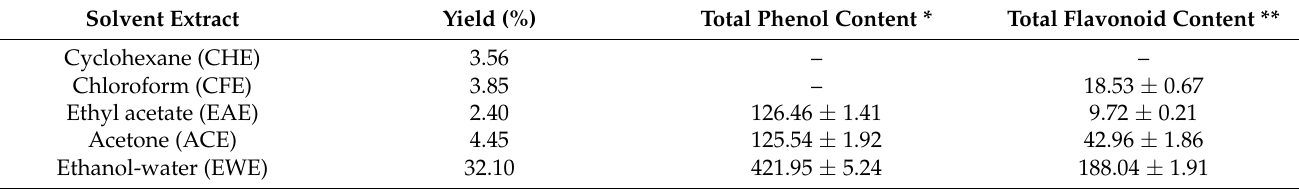
Table 1. Yield and quantitative phytochemical screening of C. aurantium peel extracts. Solvent Extract Yield (%) Total Phenol Content * Total Flavonoid Content ** Cyclohexane